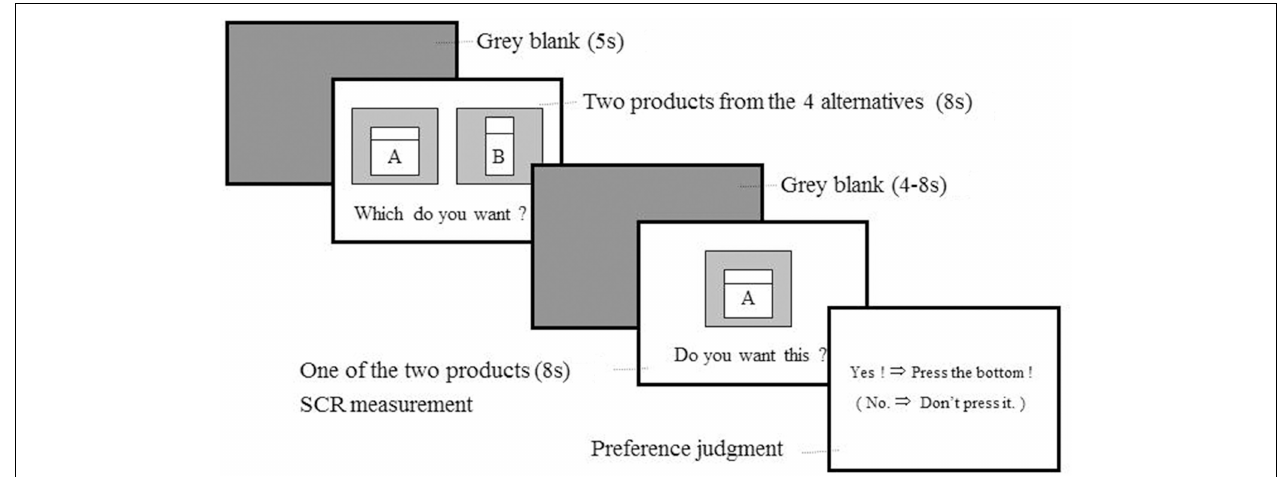
FIGURE 1 | Time sequence of a trial in the preference judgment task. First, the participant was shown images of two cosmetic products selected from four options. Then, one of the two products was presented and the participant pressed a button with her right hand if she considered the presented product to be more preferable and desirable than the other product. Each participant completed two sequences of 13